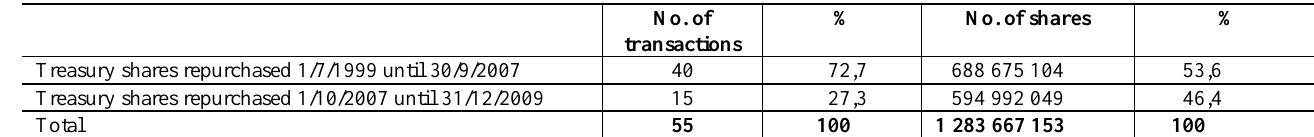
Table 5: Tax implications as a motivation for the repurchase of treasury shares from subsidiaries